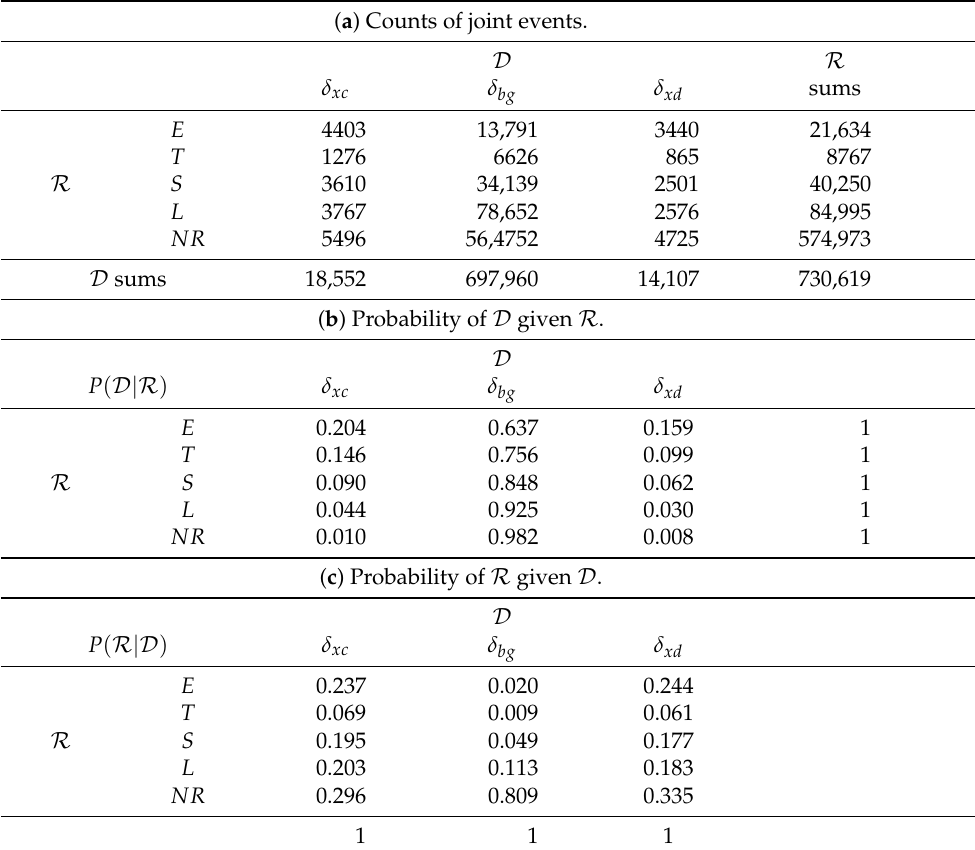
Table 6. Two-way contingency table between categories of wind divergence ( D ) and rain intensity ( R ) and conditional probability structure for observations in December